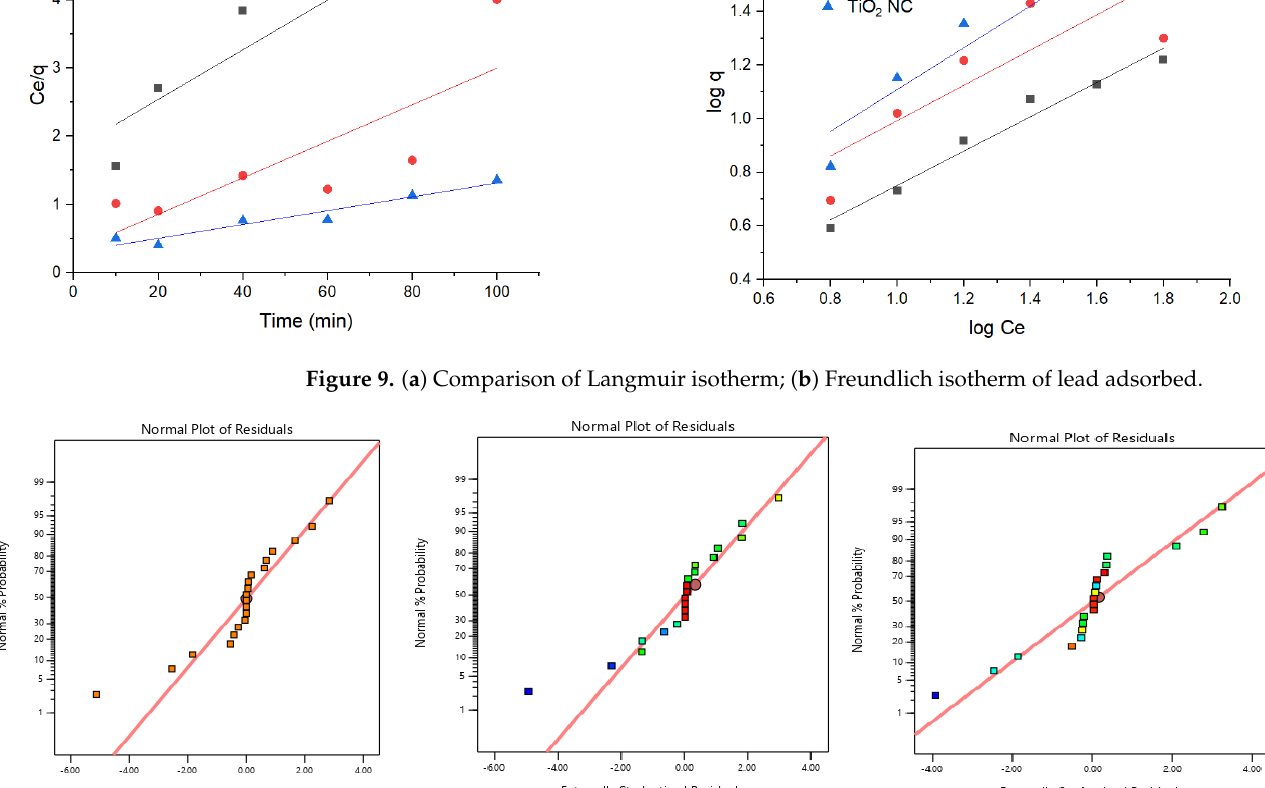
Figure 10. Studentized residuals and normal percentage probability plot for adsorbtion of Cr(VI) by ( a ) biomass; ( b ) biochar; and ( c ) TiO 2 NC. ( a ) biomass; ( b ) biochar; and ( c ) TiO 2